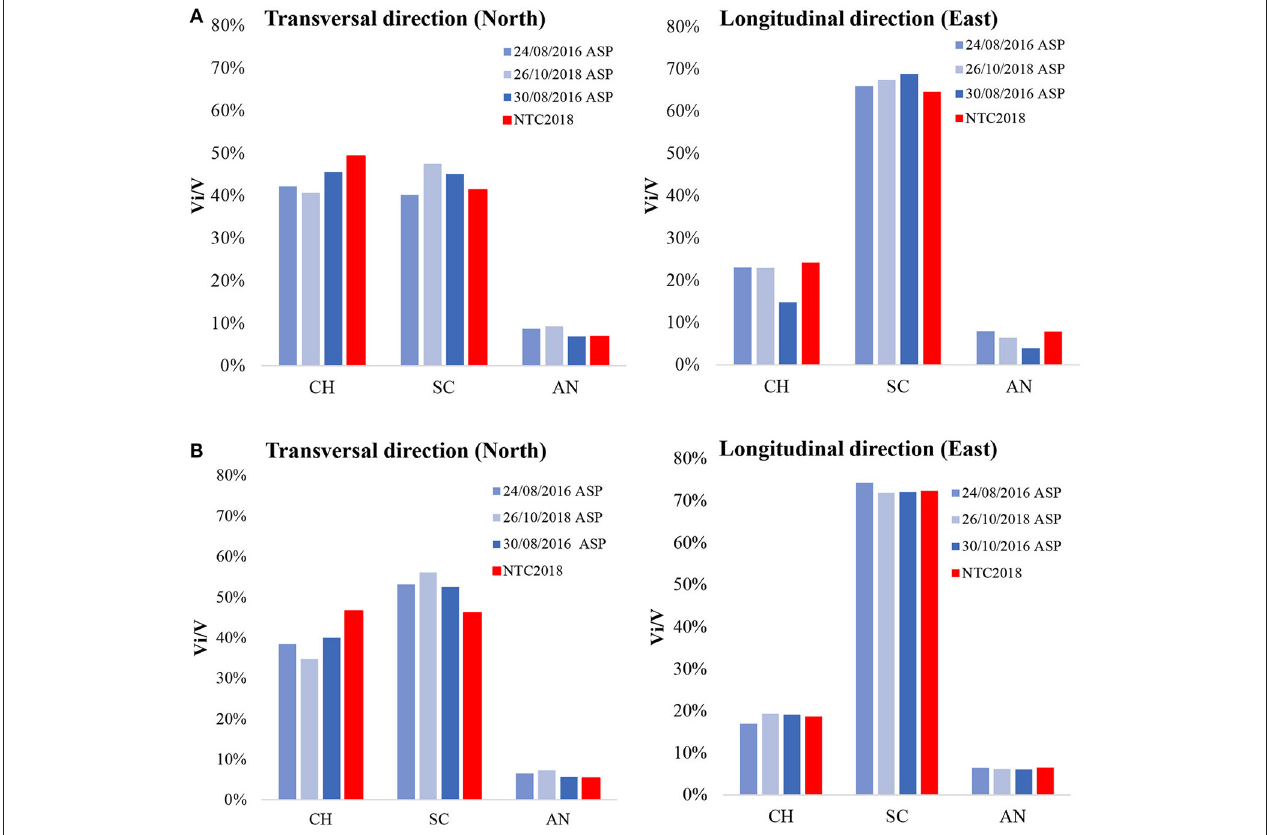
FIGURE 7 | Seismic base shear absorbed by the church (CH), the school (SC), and the annex (AN) for the Model CS (A) , Model DF (B) .